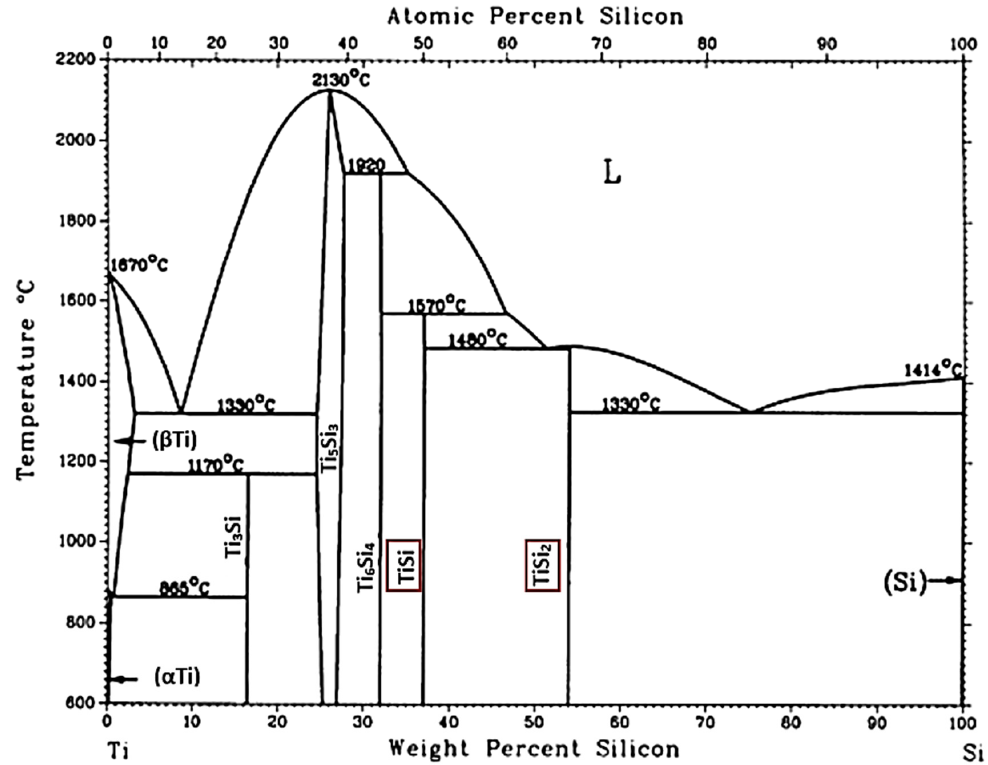
Figure 13. Equilibrium binary diagram of Ti-Si [30].